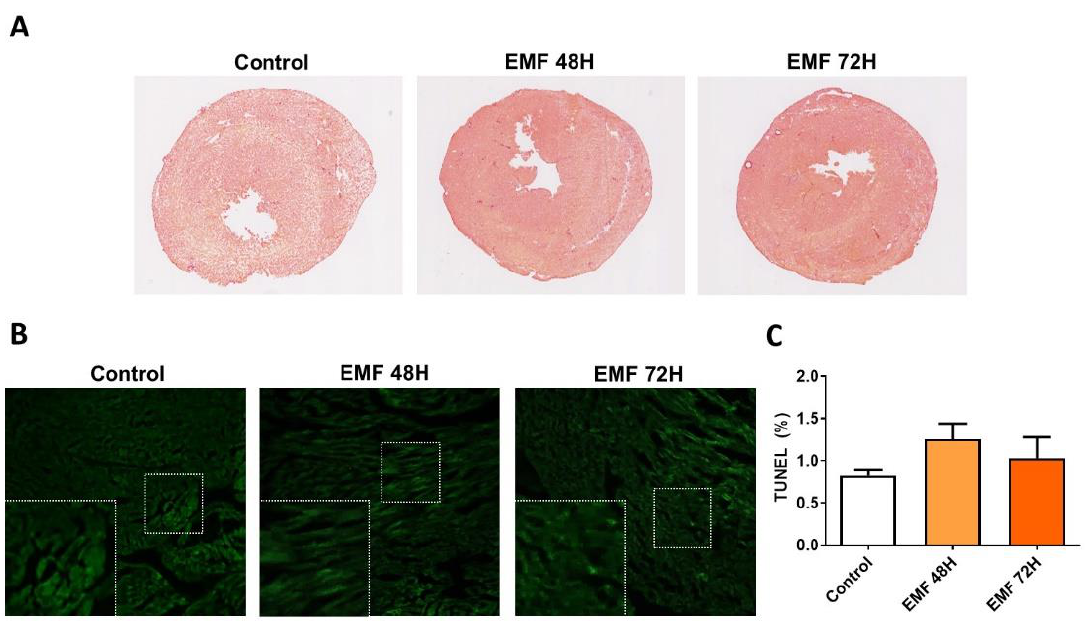
Figure 5. Effects of 915 MHz EMFs on cardiac structure and apoptosis in mice exposed for 48 h and 72 h. Representative images of cardiac sections stained with H&E ( A ). Scale bar: 2.5 mm. Repre- sentative images of cardiac sections stained with TUNEL ( B ) and quantification ( C ). Scale bar: 100 µm. The results present the mean ± SEM, n = 3.